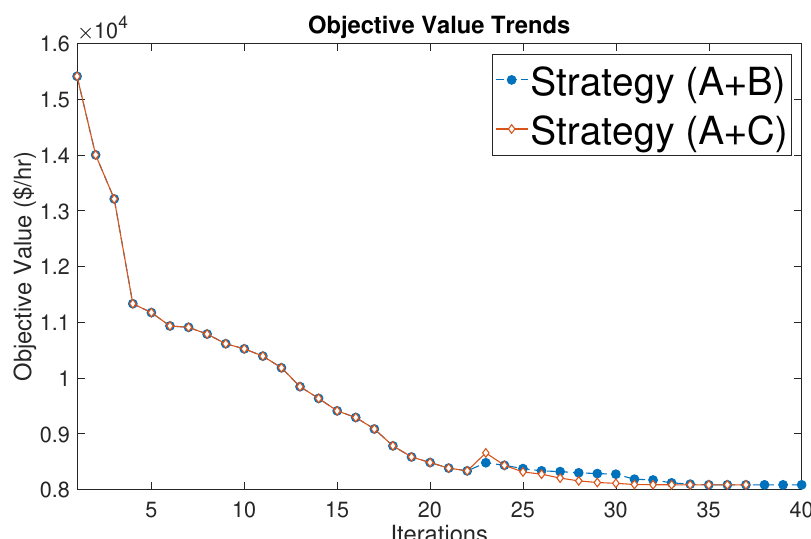
Figure 5. The 14 bus objective value. Regionalization strategies generated by AR and denote TBS-AR as strategy A, MBS-AR as B and WMBS-AR as C. Strategy A+B (blue line) is the combination of regionalization strategies A and B, Strategy A+C (red line) is the combination of regionalization strategies A and C.